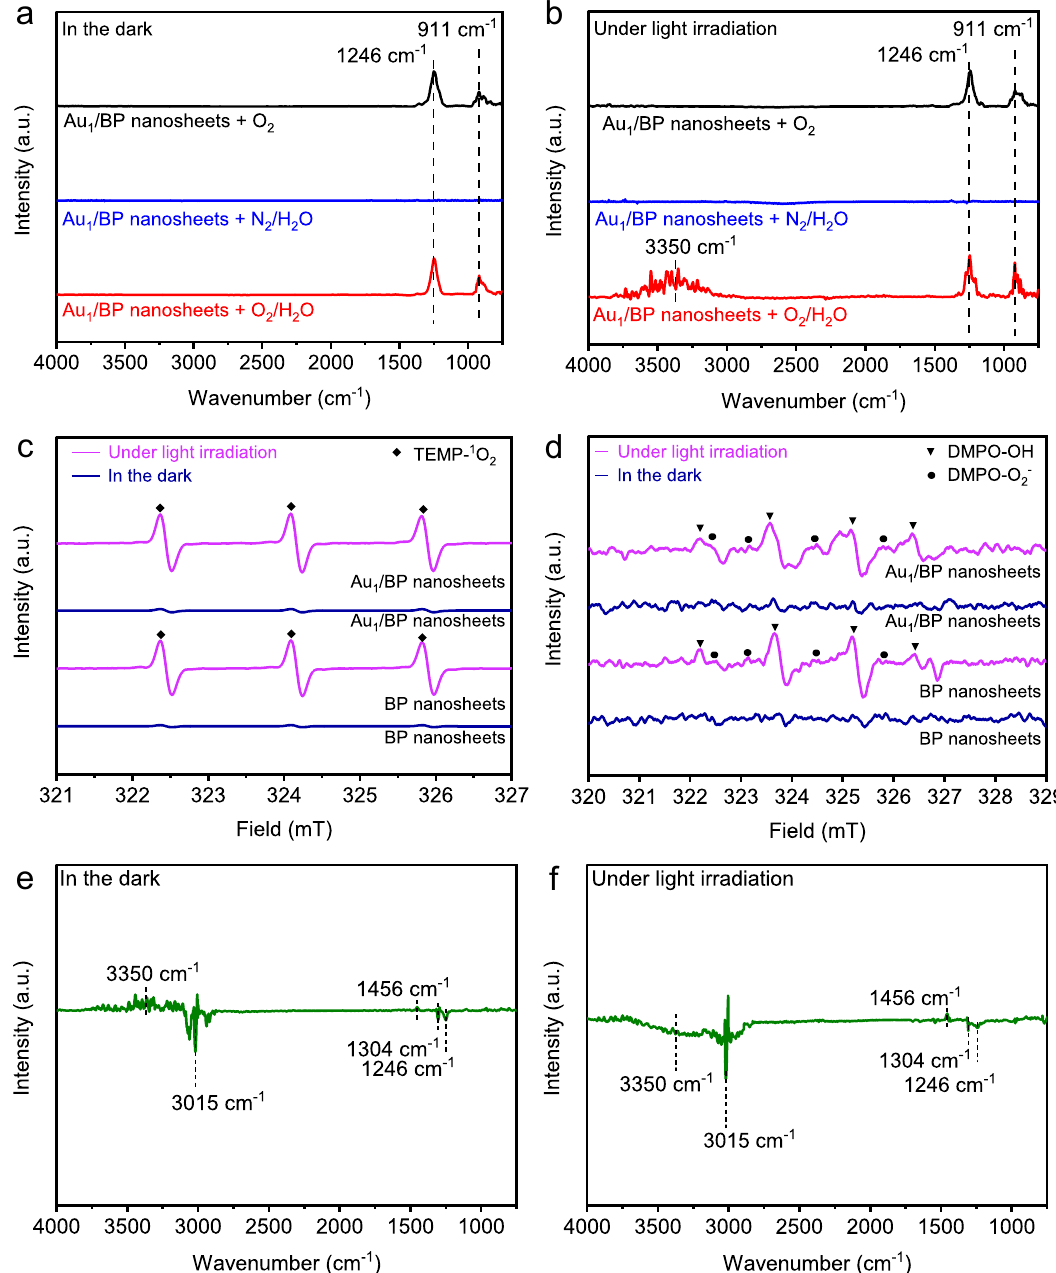
Fig. 3 Mechanistic studies. In situ DRIFTS spectra of Au 1 /BP nanosheets purged by 1 bar of different gases at 90°C ( a ) in the dark and ( b ) under light irradiation. Background spectra were acquired after fl owing under 1 bar of N 2 with the rate of 20 sccm at 150°C for 0.5 h, followed by cooling to 90°C. c In situ ESR spectra of BP and Au 1 /BP nanosheets under different conditions in the presence of TEMP. d In situ ESR spectra of BP and Au 1 /BP nanosheets under different conditions in the presence of DMPO. In situ DRIFTS spectra of Au 1 /BP nanosheets purged by 1 bar of CH 4 at 90°C ( e ) in the dark and ( f ) under light irradiation. Catalysts were purged by 1 bar of O 2 /H 2 O at 90°C for 0.5 h, followed by 1 bar of N 2 at 150°C for 0.5 h. Afterwards, the catalysts were purged by 1 bar of CH 4 at 25°C for 0.5 h to obtain background